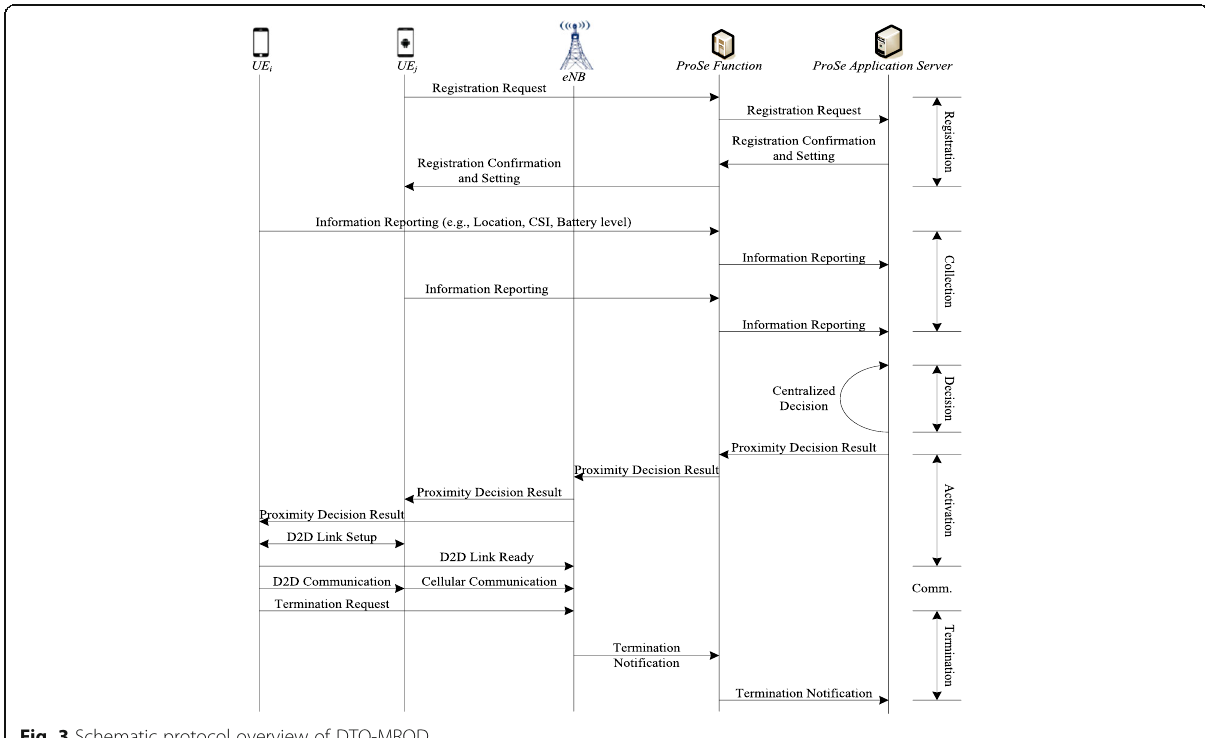
Fig. 3 Schematic protocol overview of